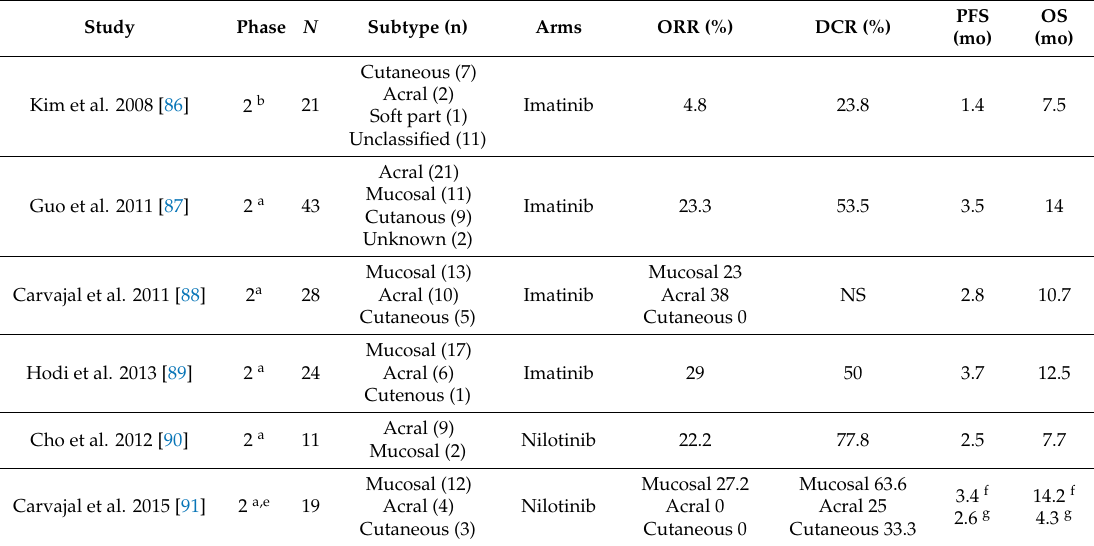
Table 2. Selected clinical trials that assessed KIT inhibitors in